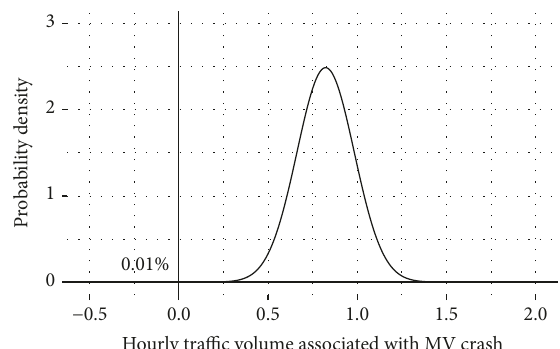
Figure 1: Distribution of hourly traffic volume associated with MV